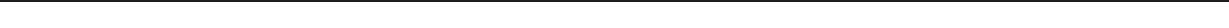
Fig. 2 Gene editing in intact pre-implantation embryos transduced with rAAV vectors. a Schematic representation of the strategy to transduce C57BL/6NJ zygotes with rAAV vectors designed to target the Tyrosinase ( Tyr ) locus. Zygotes were placed in KSOM containing rAAV6- Cas9 and rAAV6-sg Tyr vectors, rinsed, cultured at 37 °C for 3 days, and analyzed for Tyr gene editing at compacted morula or blastocyst stages. Alternatively, they were cultured overnight and transferred at the 2-cell stage into the oviducts of E0.5 pseudopregnant females. Transferred embryos were assessed for eye pigmentation at E16.5, or allowed to develop to birth and assessed for eye and coat color pigmentation. b Stacked histogram showing the percentage distribution of indel-type frequencies among four rAAV-dosage groups . Alterations indicate base replacements; large deletions are de fi ned as removal of > 20 bases and compound mutations are combinations of insertions, deletions, and/or alterations. c Analysis of eye pigmentation in E16.5 embryos transduced with rAAV6- Cas9 only (left panel) and both rAAV6 -Cas9 and rAAV6 - sg Tyr (right panel). Arrow in the right panel indicates the location of the eye in a transduced albino embryo. d Albino litter generated after transduction of C57BL/6NJ zygotes with CRISPR- Cas9 rAAV vectors at 6 × 10 9 GC dose. Shaved area on female indicates site of embryo transfer surgery. e A representative litter obtained after transduction of C57BL/6NJ zygotes with CRISPR-Cas9 rAAV vectors at 6 × 10 8 GC dose. Three out of fi ve pups are albino and two are mosaic as revealed by the variegated coat color pattern. f Schematic representation of the strategy to test germline transmission of CRISPR-Cas9-induced alleles of Tyr . Tyr -edited albino mice were mated with albino CD-1 ( Tyr c/c ) animals and the offspring were assessed for the presence of albino coat color. g Litter derived from Tyr -edited albino male crossed with a CD-1 female. All pups are albino